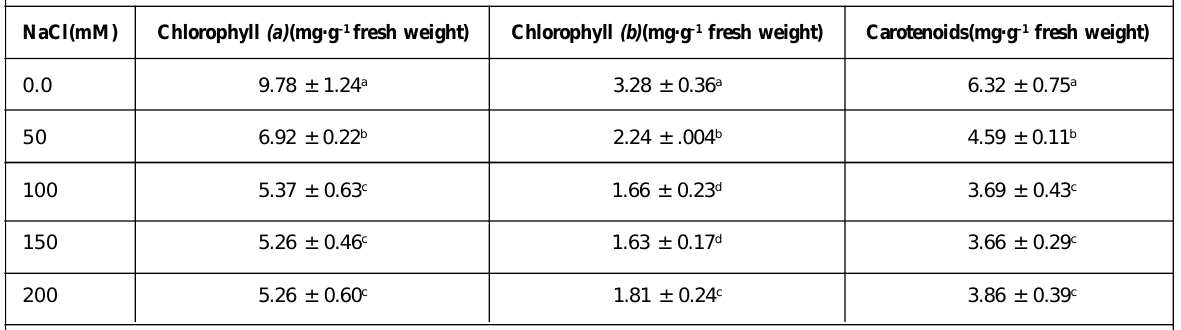
Table 4: Impact of different concentrations of NaCl on chlorophylls (a and b) and carotenoids in Phaseolus vulgaris L.